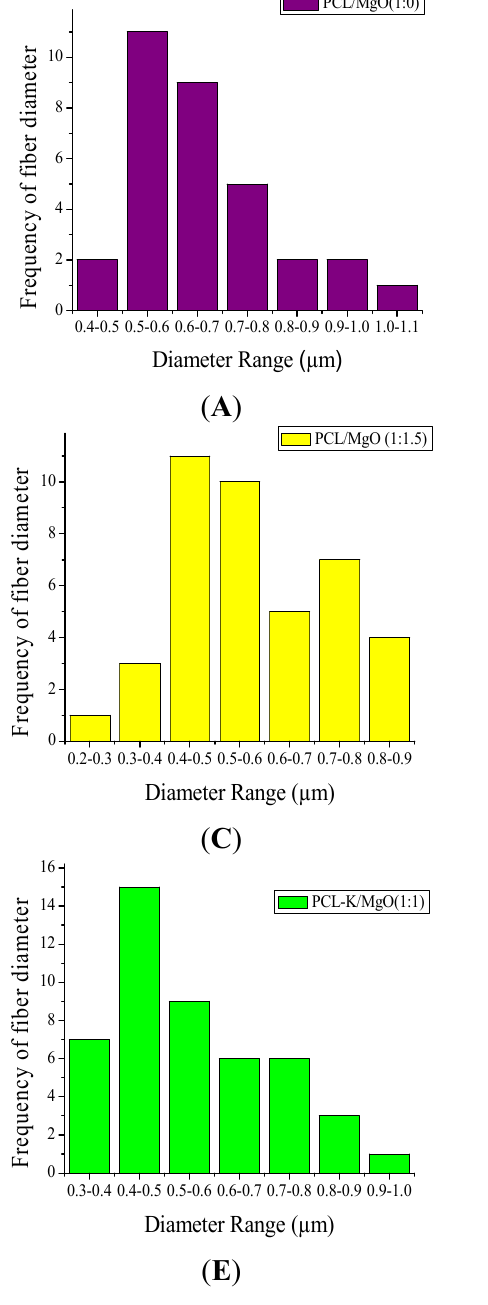
Figure 2. Size distribution of nanofibers: fiber diameters from SEM images of Figure 1A ( A ), Figure 1F ( B ), Figure 1G ( C ), Figure 1H ( D ), Figure 1I ( E ) were measured by using Image-Pro Plus 6.0